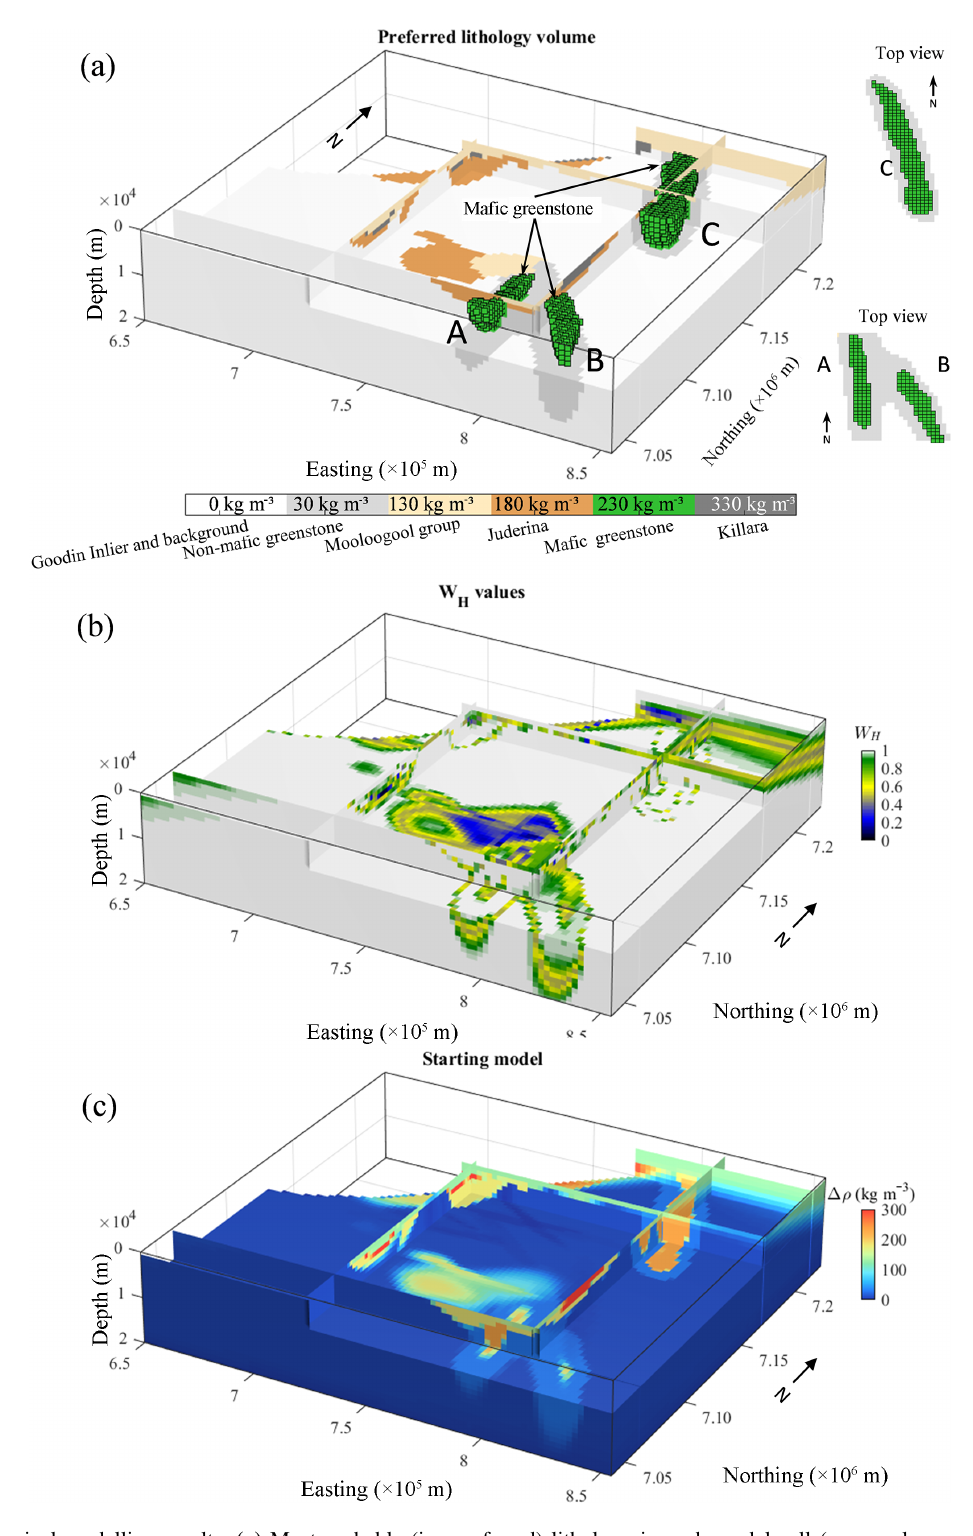
Figure 7. Geological modelling results. (a) Most probable (i.e. preferred) lithology in each model cell (same colour code as in Fig. 6), (b) values used for local regularization conditioning, and (c) prior model derived from PGM and prior petrophysical information. In (a) , “background” refers to all the lithologies that have a density contrast equal to 0kgm − 3 .